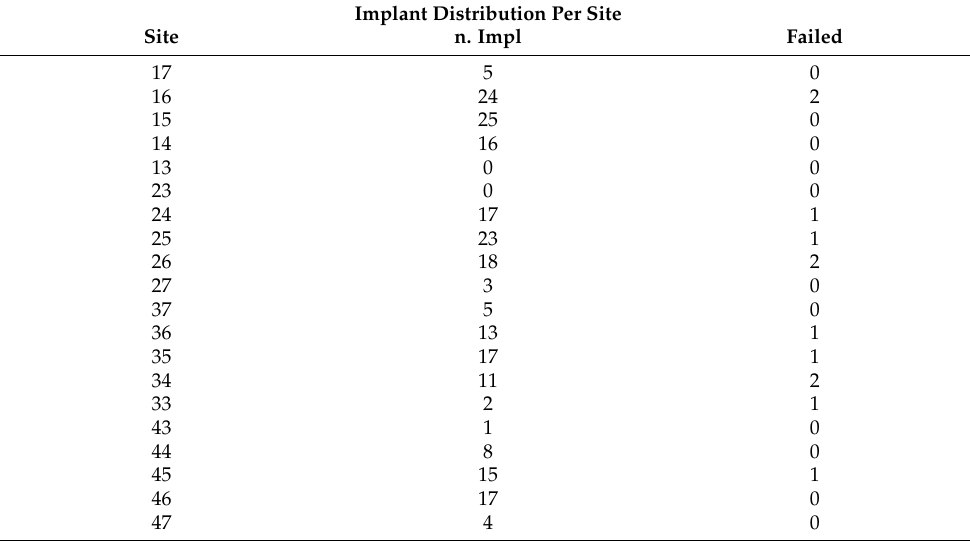
Table 3. Summary of the implant size distribution.